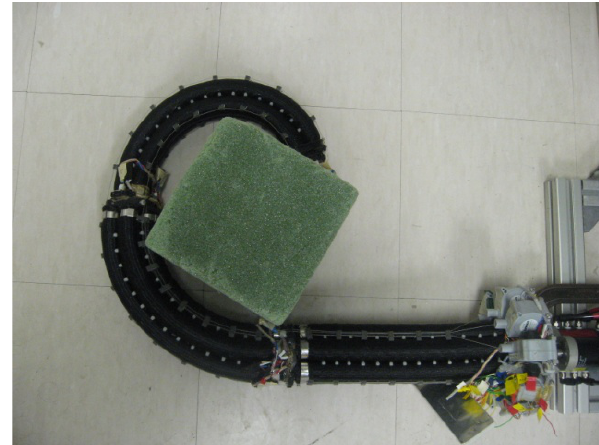
Figure 7. Object held by point contacts